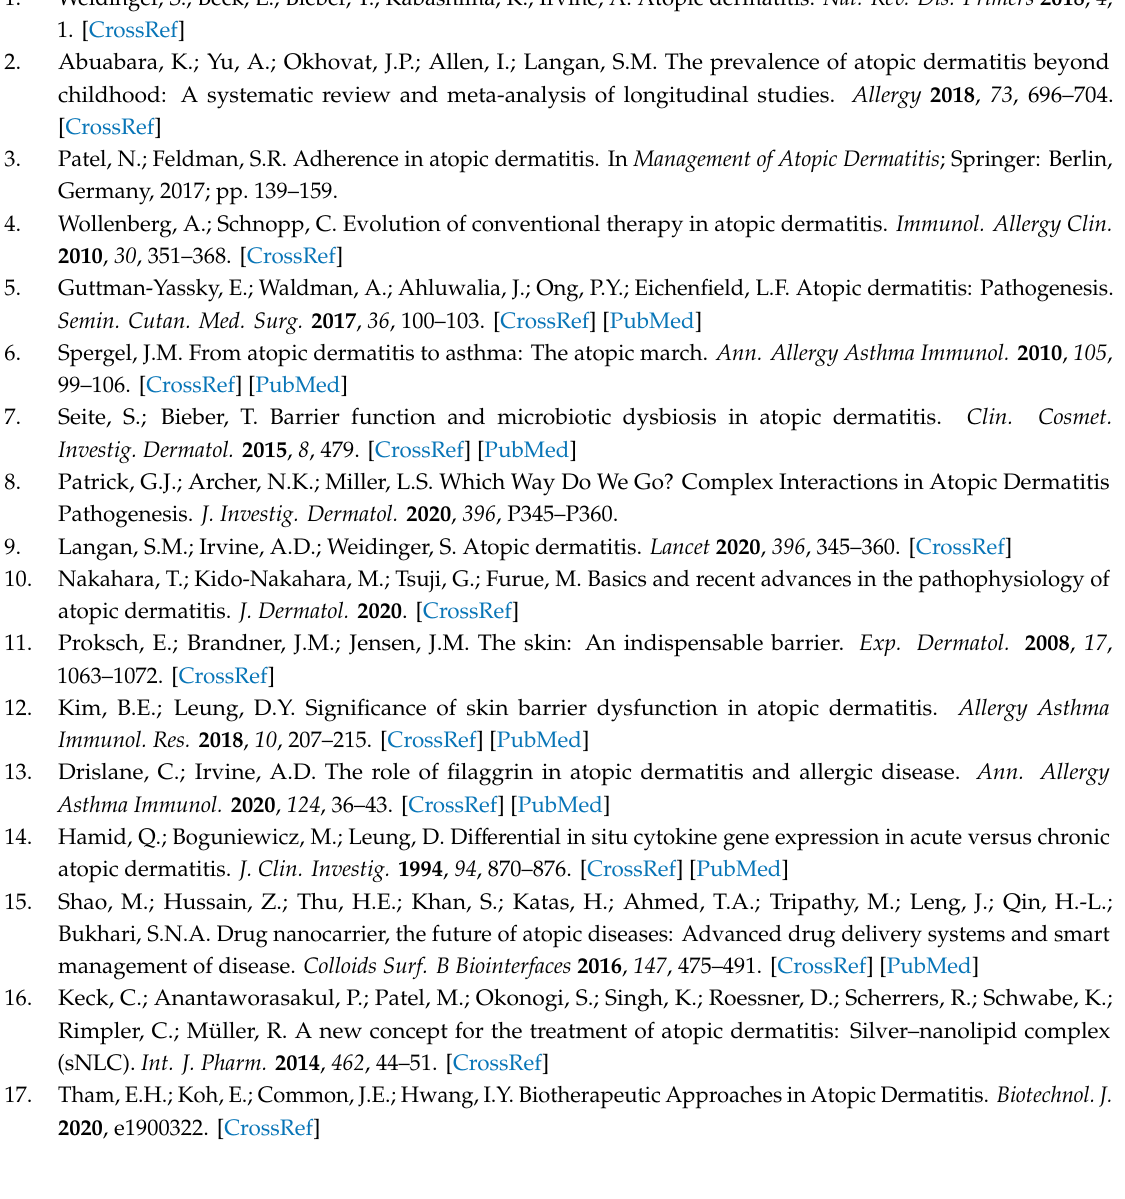
Table S1: Restoration of healthy skin microbiota, Table S2: Drug Delivery System (DDS) for AD